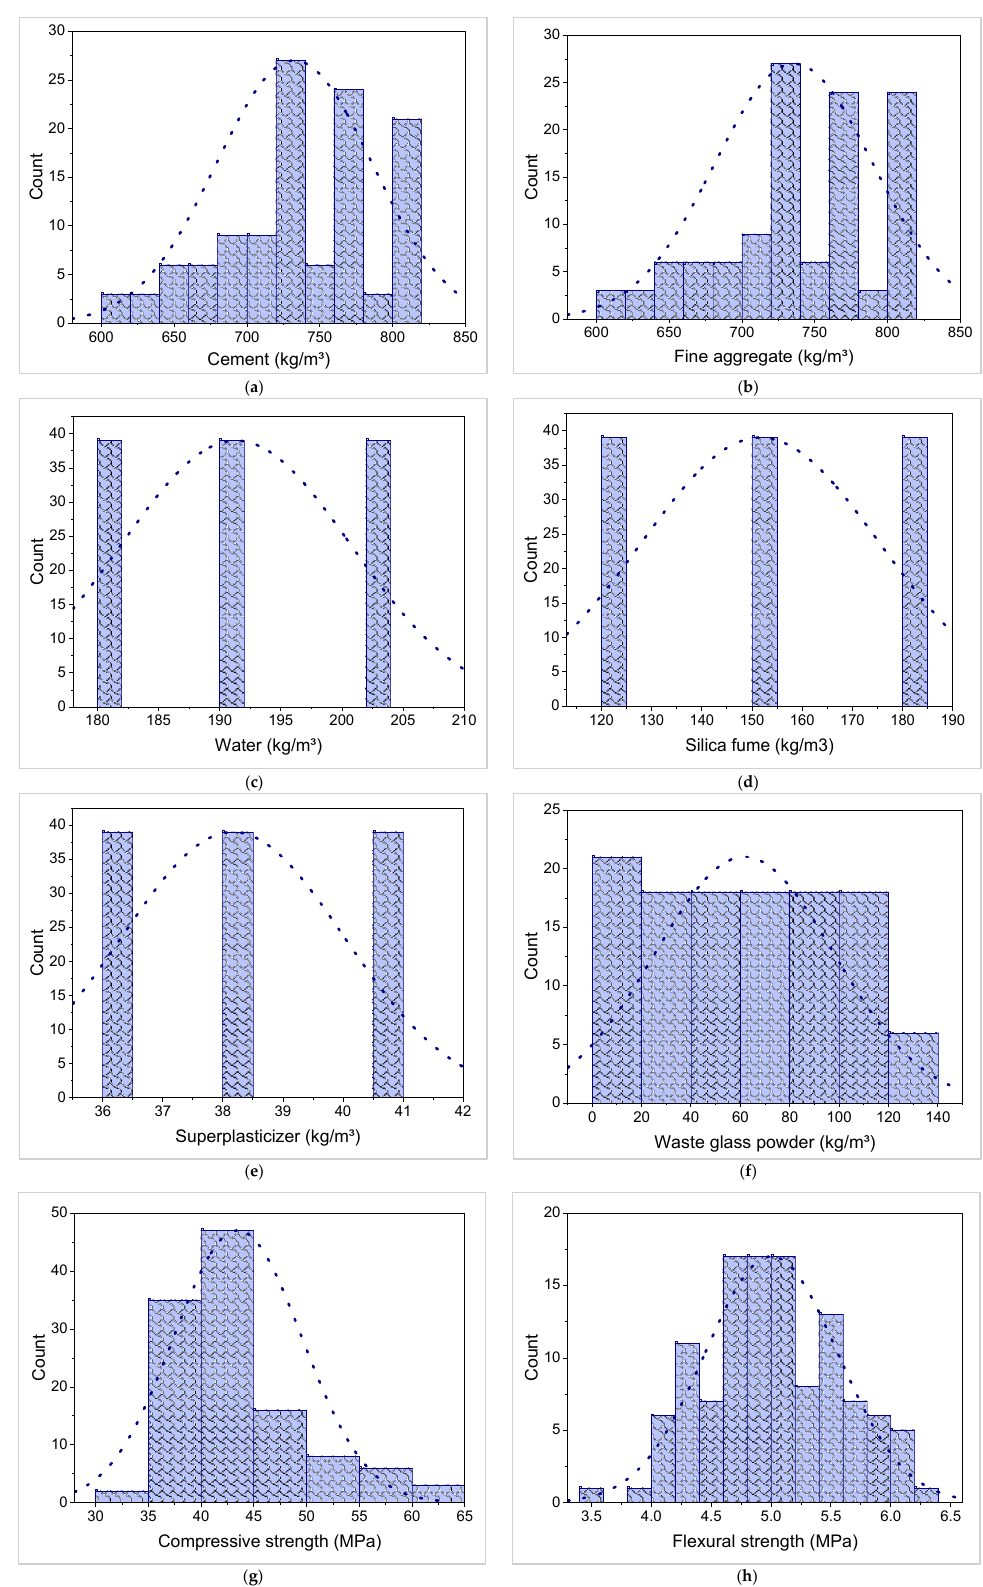
Figure 1. Relative frequency dispersal of input and output parameters: ( a ) Cement; ( b ) Fine aggregate; ( c ) Water; ( d ) Silica fume; ( e ) Superplasticizer; ( f ) Waste glass powder; ( g ) Compressive strength; ( h ) Flexural strength.